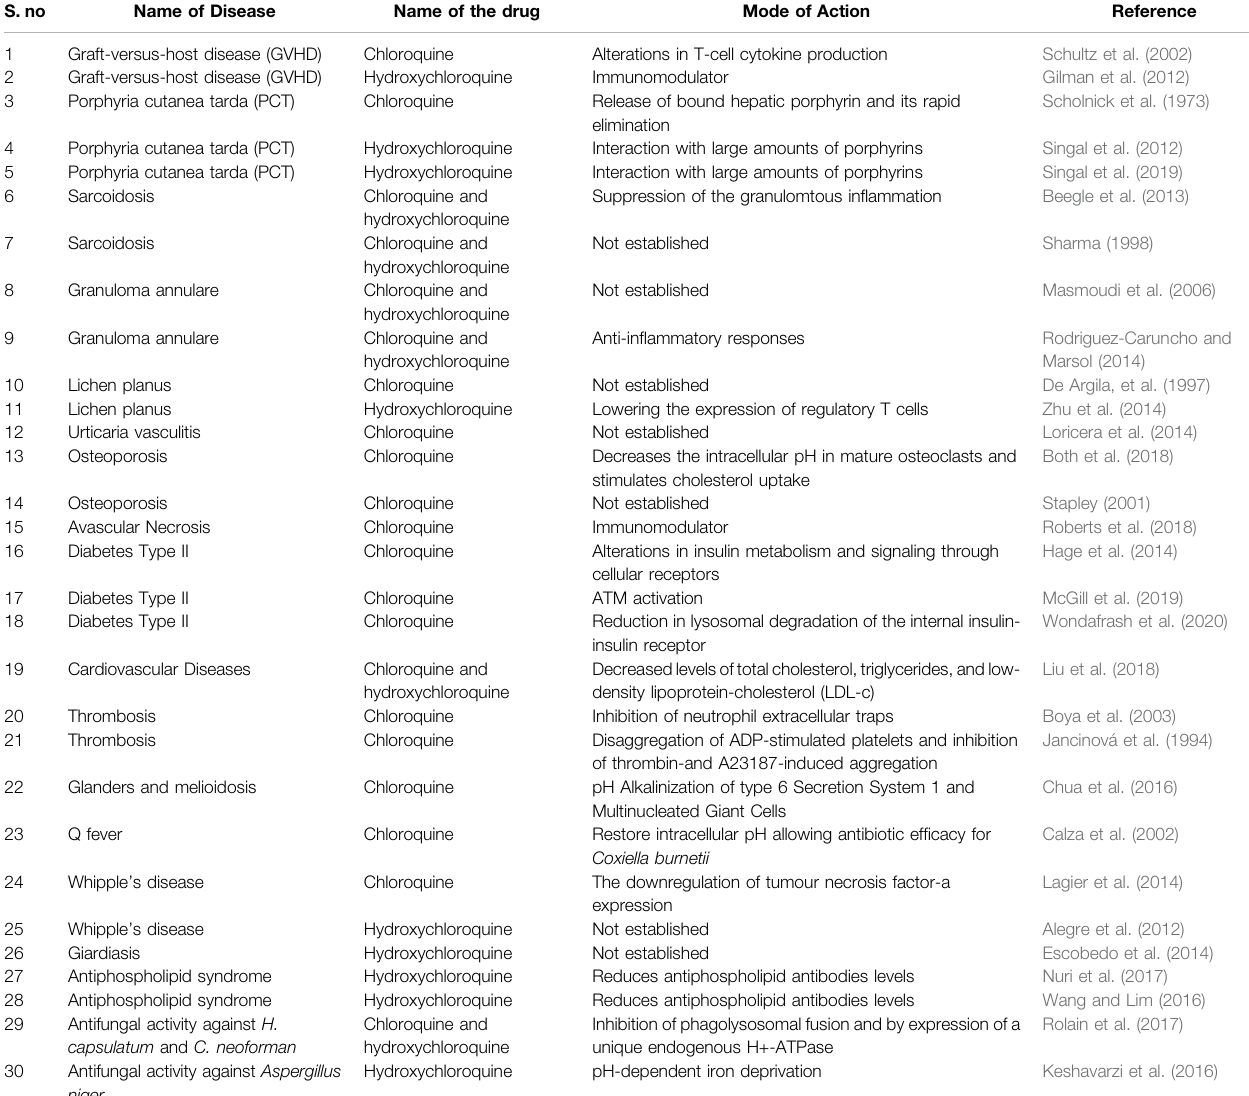
TABLE 3 | Examples of chloroquine used in treatment of multiple diseases. S.